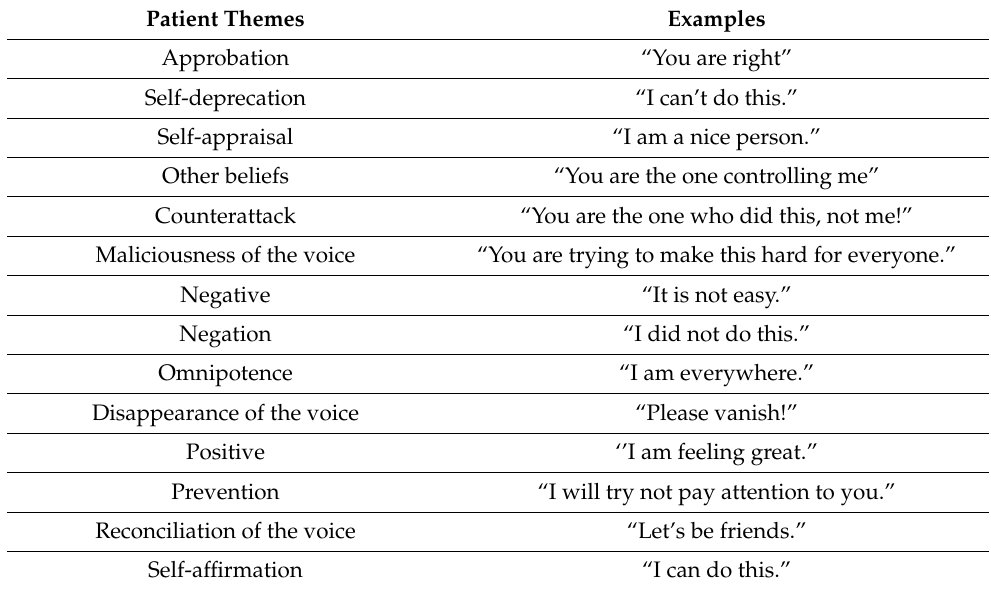
Table 2. Patient interactions’ themes as per Beaudoin et al. 2021.